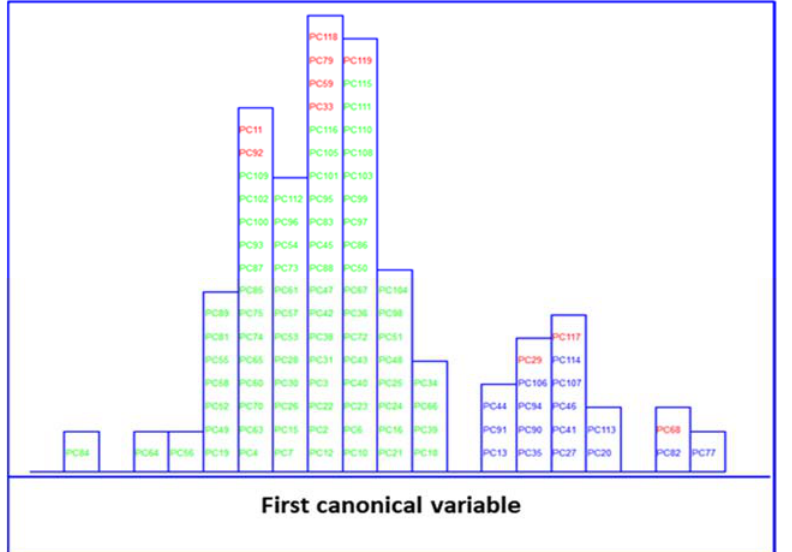
Figure 4. Histogram of the first canonical variable for the discrimination of MetS (  ) and no MetS (  ) patients within included (  ) test set, after performing LDA in the stratification approach based on clinical parameters ( y ‐ axis indicates the maximum discrimination power between categories).